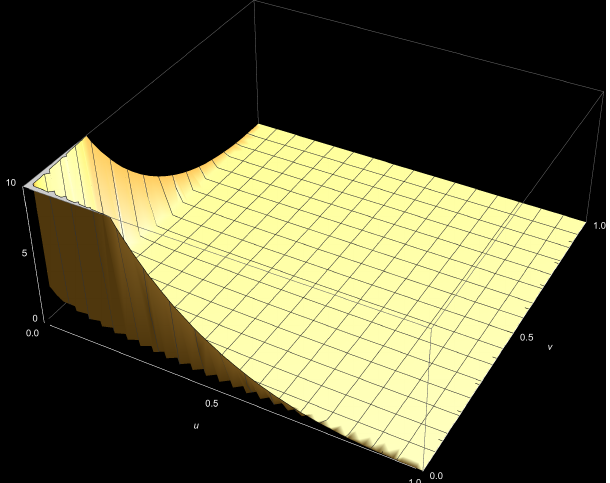
Figure A3. The bivariate Kumaraswamy density (Equation (1)) plot, where α = 0.8, β = 0.8, θ = 0.2 and δ =